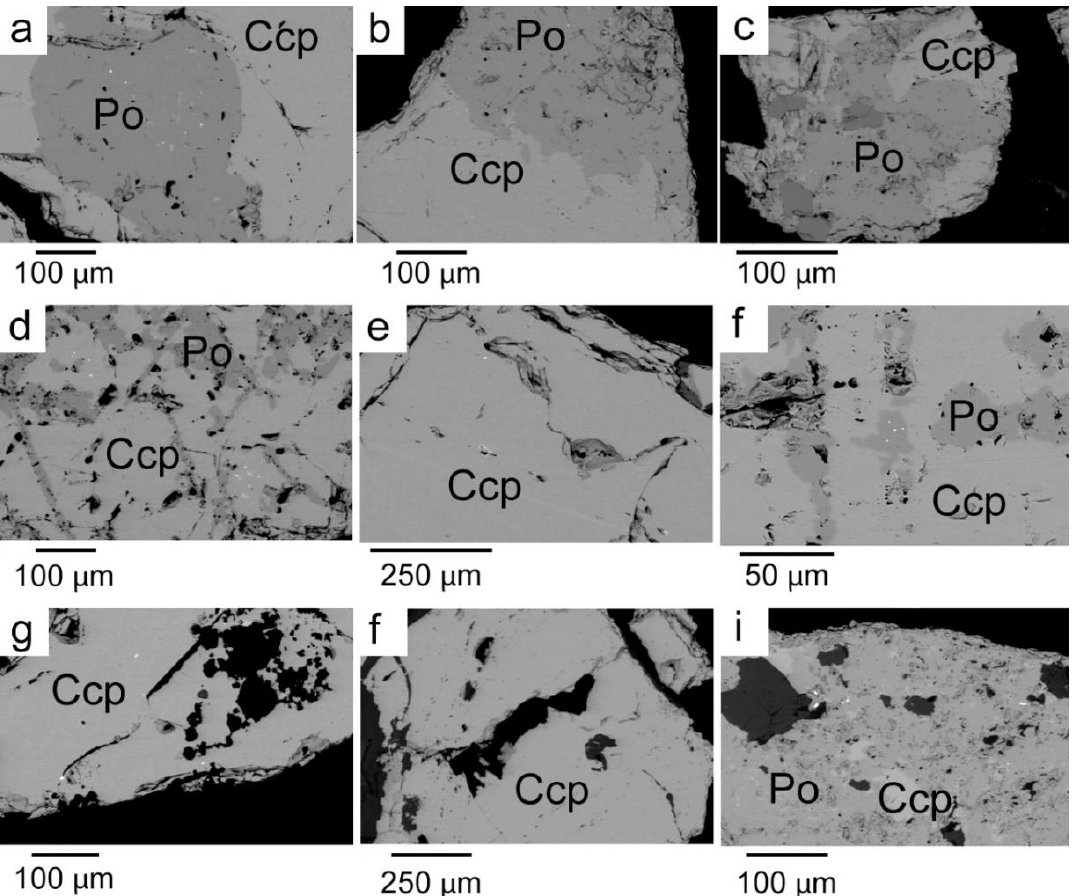
Figure 3. BSE images of chalcopyrite grains of massive ( a – c ), disseminated ( d – f ) and veinlet-disseminated ( g – i ) ores, respectively. Ccp—chalcopyrite, Po—pyrrhotite. Pentlandite is also present as small-size flames, which are too small to be indicated at the selected scale.